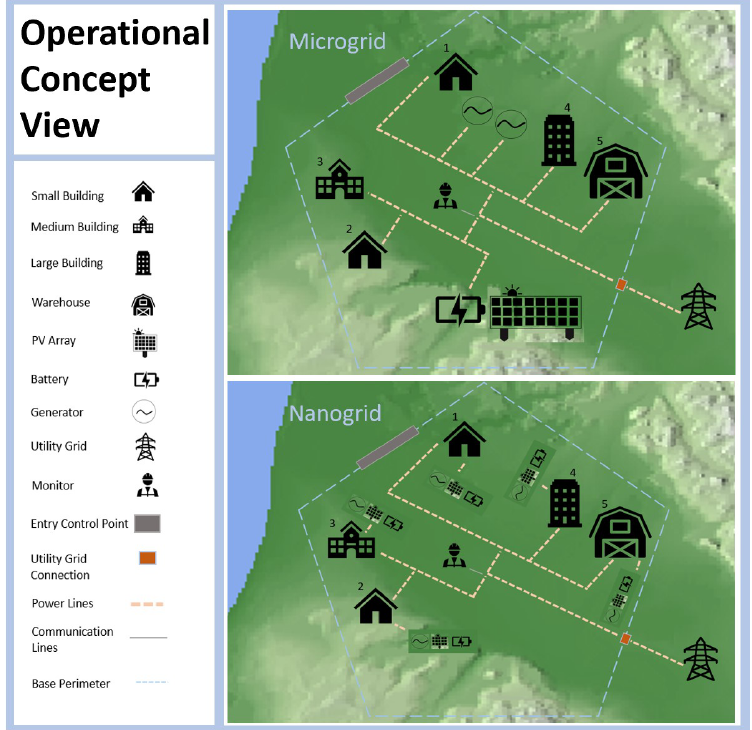
Figure 6. Operational Concept View of Naval Support Activity Monterey. Baseline microgrid is represented in the top diagram while the proposed microgrid augmented with nanogrids is represented in the bottom diagram.